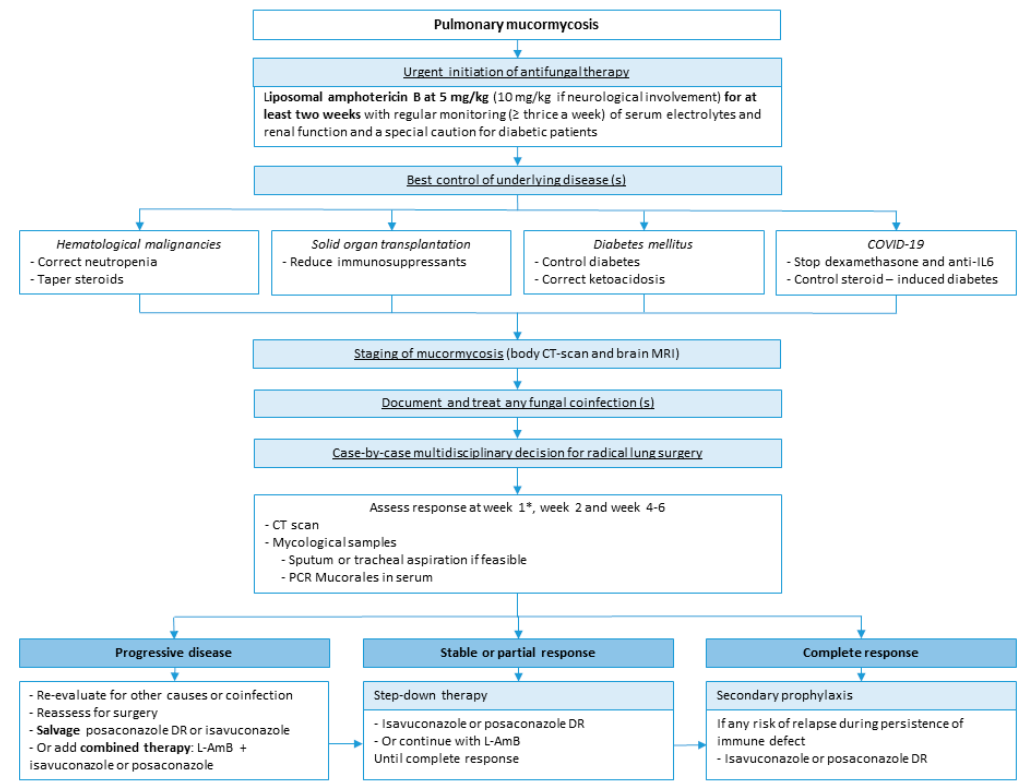
Figure 5. legend Summary of PM management. * Reevaluation at week 1 should be done with cau ‐ tion. A paradox ‐ ical worsening is possible after neutrophil recovery and should not be considered as a progression of the disease.